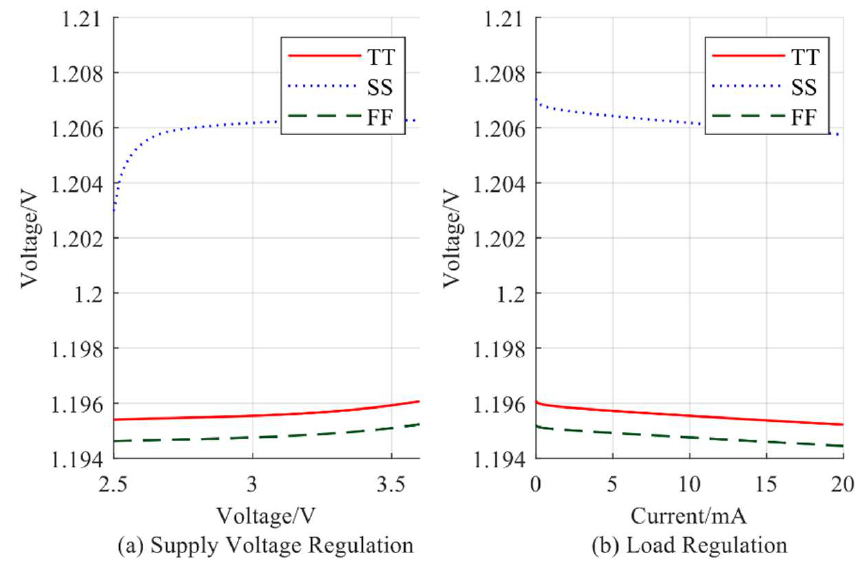
Figure 11. Supply voltage regulation and load regulation.